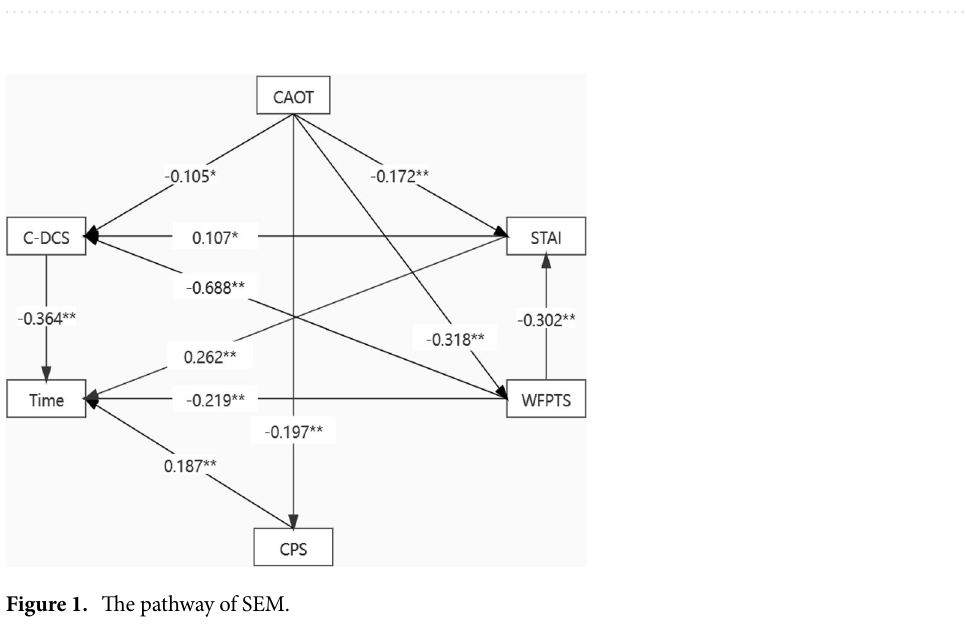
Table 7. The goodness-of-fit indices of the SEM (n = 231).